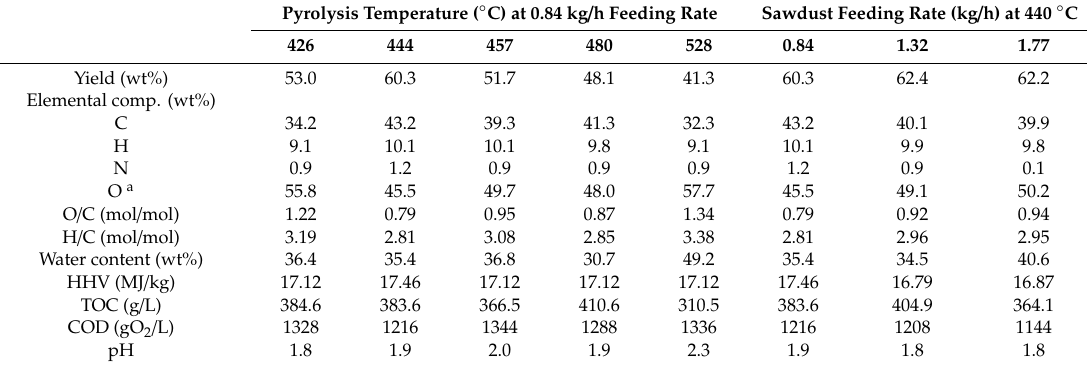
Table 2. Effect of pyrolysis temperature and feeding rate on the fuel characteristics of bio-oil. Pyrolysis Temperature (°C) at 0.84 kg/h Sawdust Feeding Rate